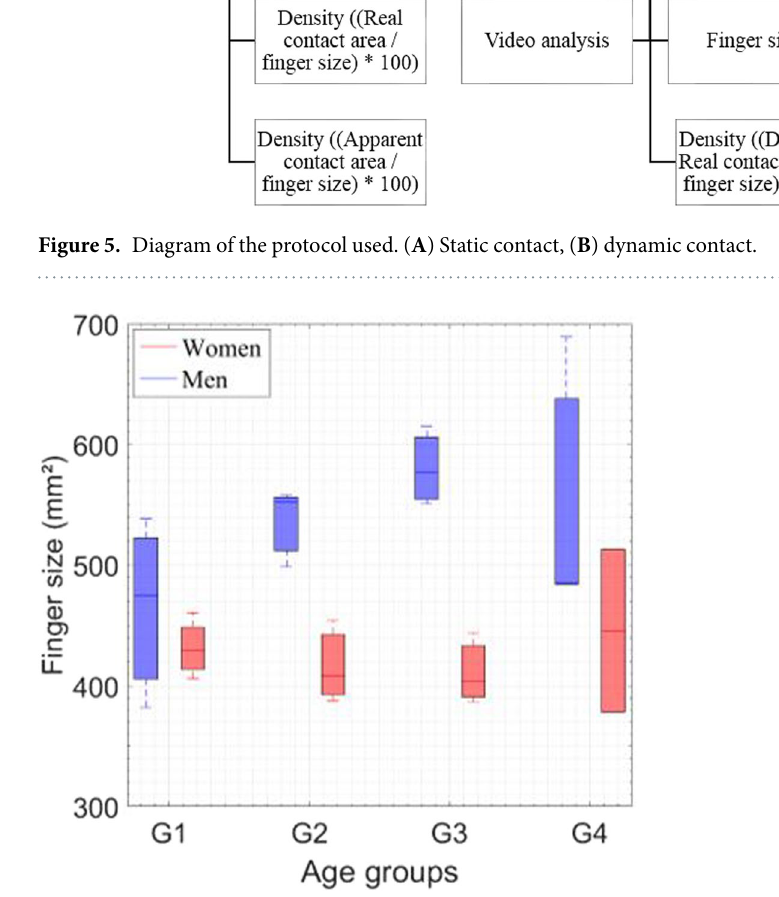
Figure 6. Finger size as function of age groups for men and women. Correlation result between finger size and age groups for men and women is illustrated. The four age groups (G1, G2, G3, and G4) correspond to (26 ± 3, 35 ± 3, 45 ± 2, and 58 ± 6 years old), respectively, for men and women. Pearson’s statistical analyses: ( + for r > 0.8, − for r < − 0.8) highly correlated, (0) for no correlation, R indicates the correlation results, * p < 0.05 for statistically significant. The statistics analysis shows significantly larger finger size for men for all age groups (p <